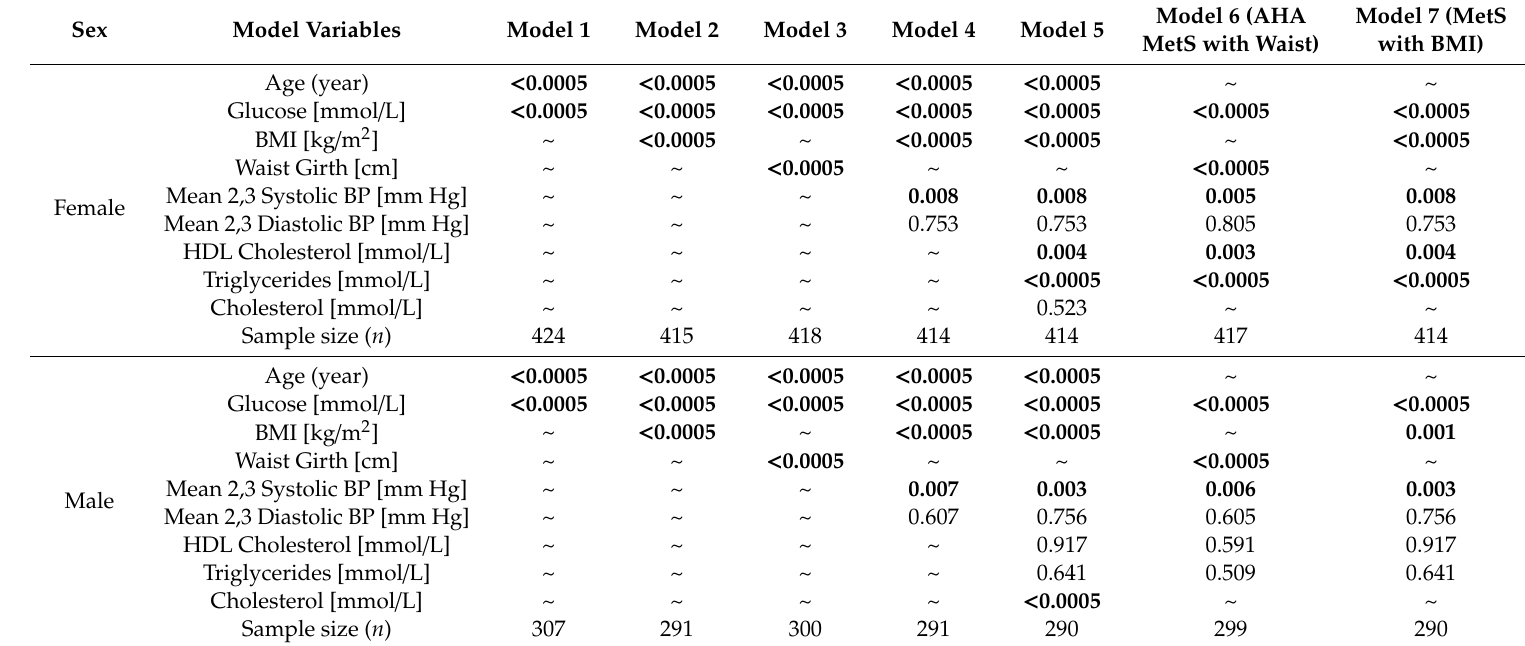
Table 2. Wilk’s Lambda tests of equality of group (type 2 diabetes mellitus, T2DM and non-T2DM) means: p -values for